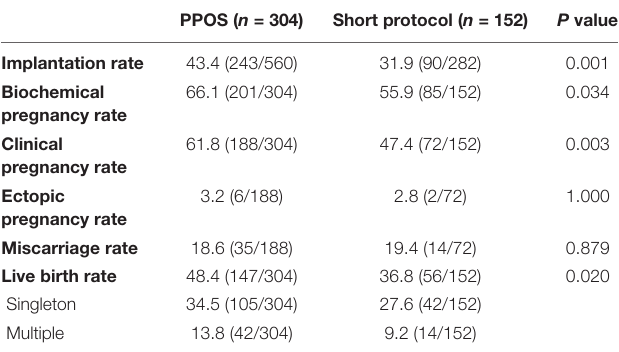
PPOS ( n = 304) Short protocol ( n = 152) P value Implantation